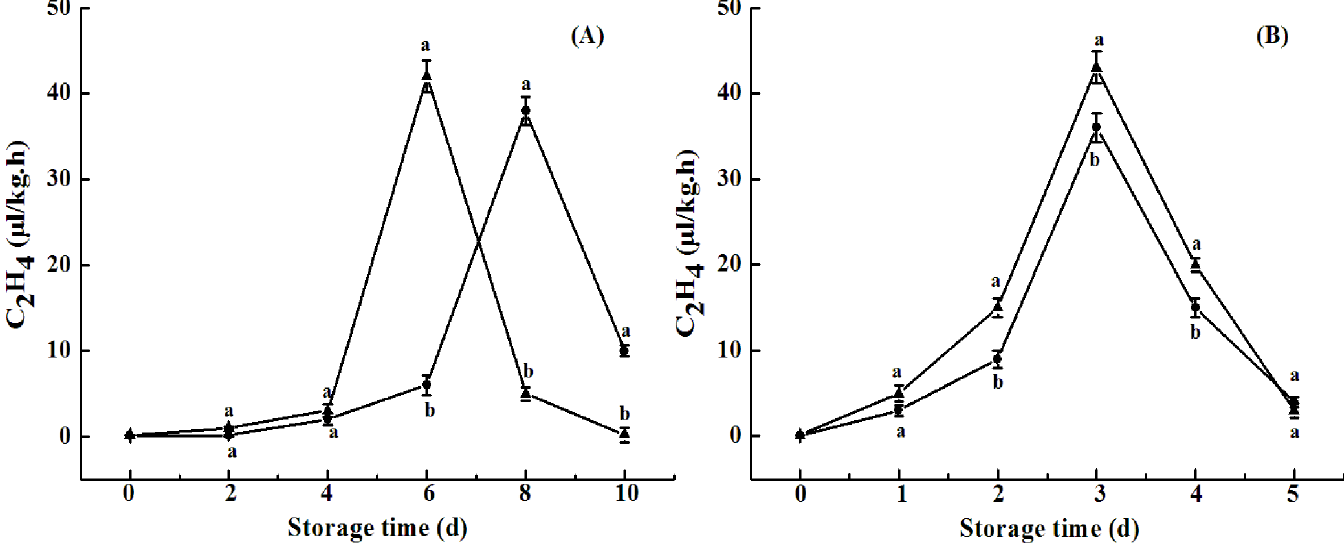
Fig 9. Ethylene production rate of avocado fruits upon natural (A) or ethylene-induced (B) ripening with ( ● ) or without ( ▲ ) cold shock treatment (CST) during 10- or 5-day storage at 20˚C and 85–90%RH. Vertical bars represent the standard error of three replicates. Different letters at any storage time indicatesignificantdifferences (P <